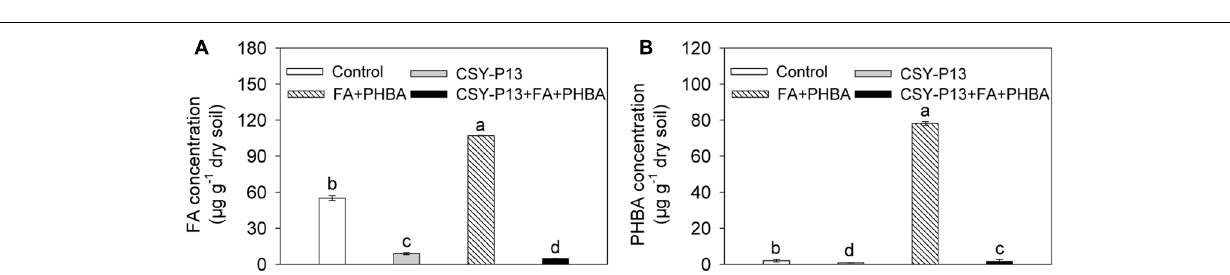
decreased by 36.65% ( P < 0.001), 33.18% ( P < 0.001), and 26.96% ( P < 0.01),